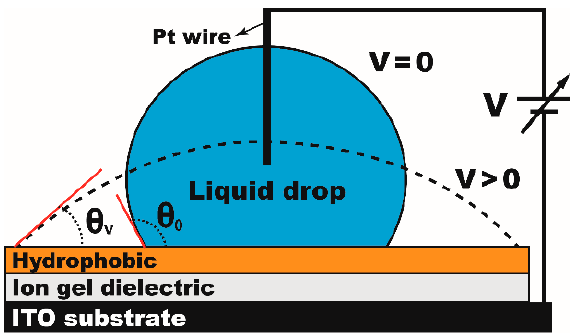
Figure 3. Experimental setup for static EWOD tests. A water droplet is placed on the ITO substrate dip-coated with the dielectric (ion gel) and hydrophobic (Teflon AF) layers.